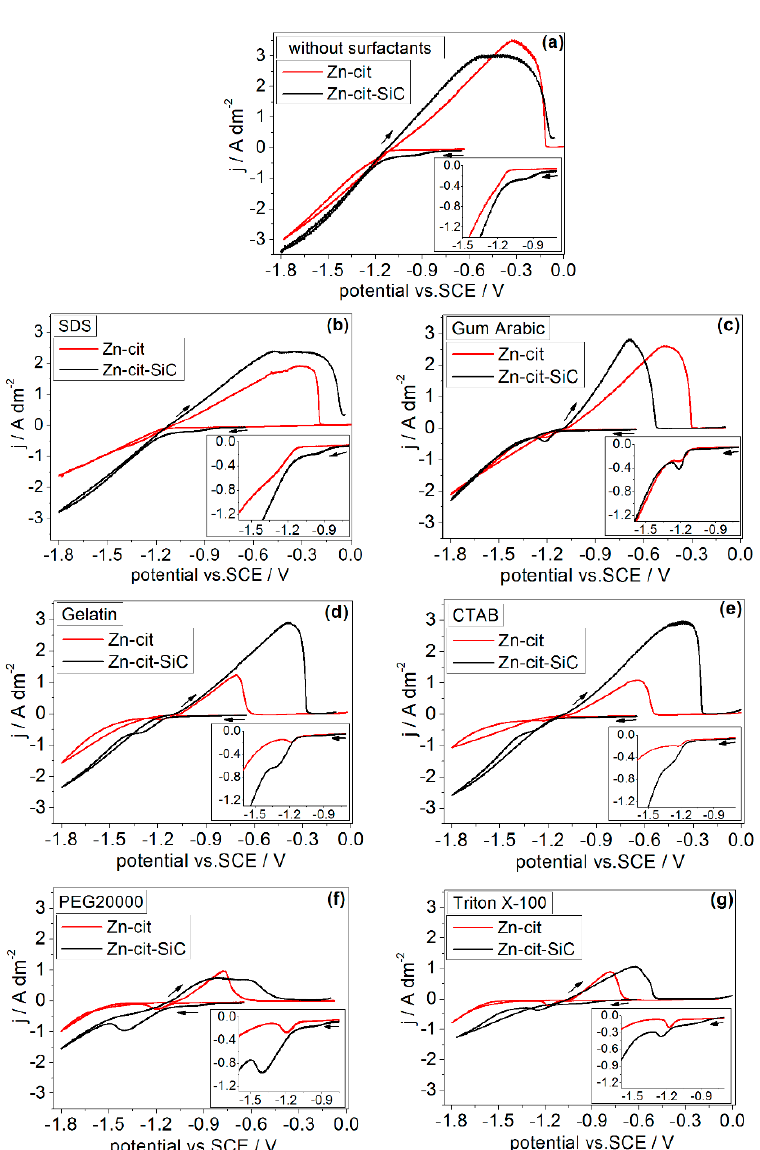
Figure 4. Cyclic voltammograms measured on a Cu substrate in Zn–cit and Zn–cit–SiC electrolytes with or without surfactants: ( a ) Without additives, ( b ) sodium dodecyl sulphate (SDS), ( c ) gum arabic (GA), ( d ) gelatin, ( e ) CTAB, ( f ) PEG, ( g ) Triton X–100. ω = 30 rad·s –1 , scan rate = 20 mV·s –1 , T = 20 °C. Arrows indicate scan direction.